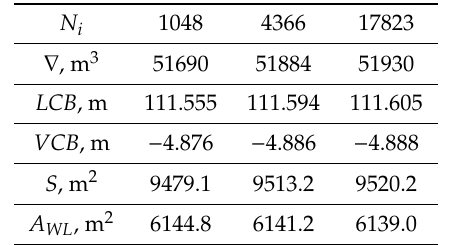
Figure 5. Comparison of the numerically obtained heave ( left ) and pitch ( right ) transfer functions with available experimental data [36–38].